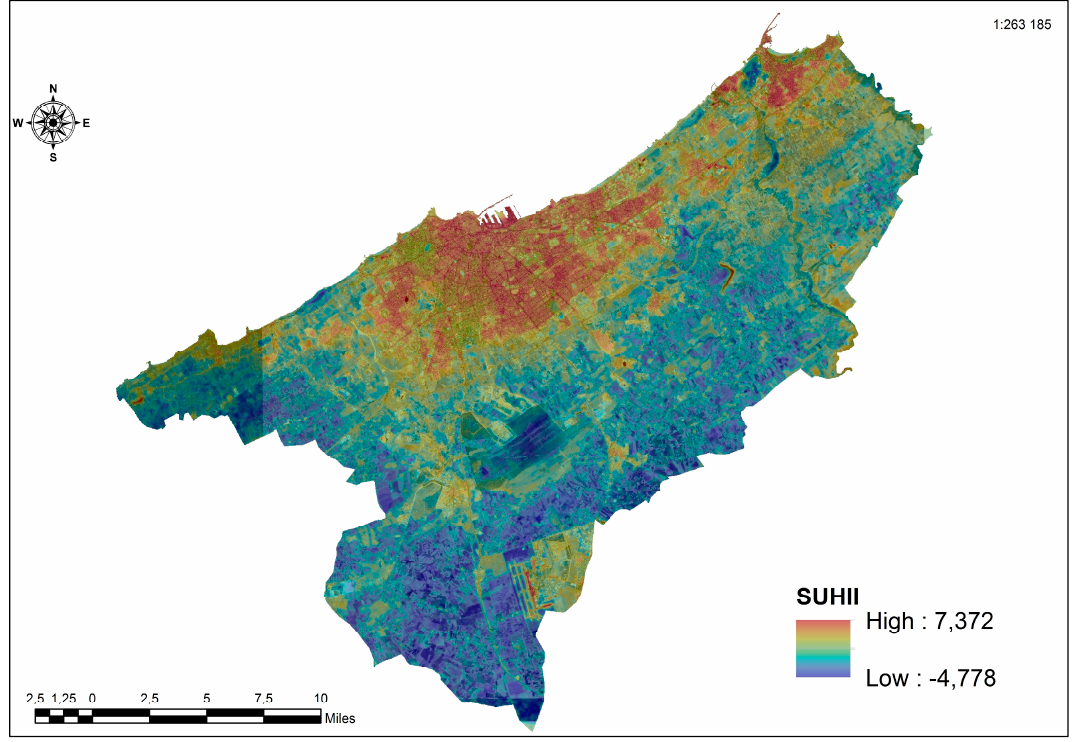
Figure 16. Spatial distribution of nighttime SUHII retrieved from OLI/TIRS on 17 June 2015 at 22:22.